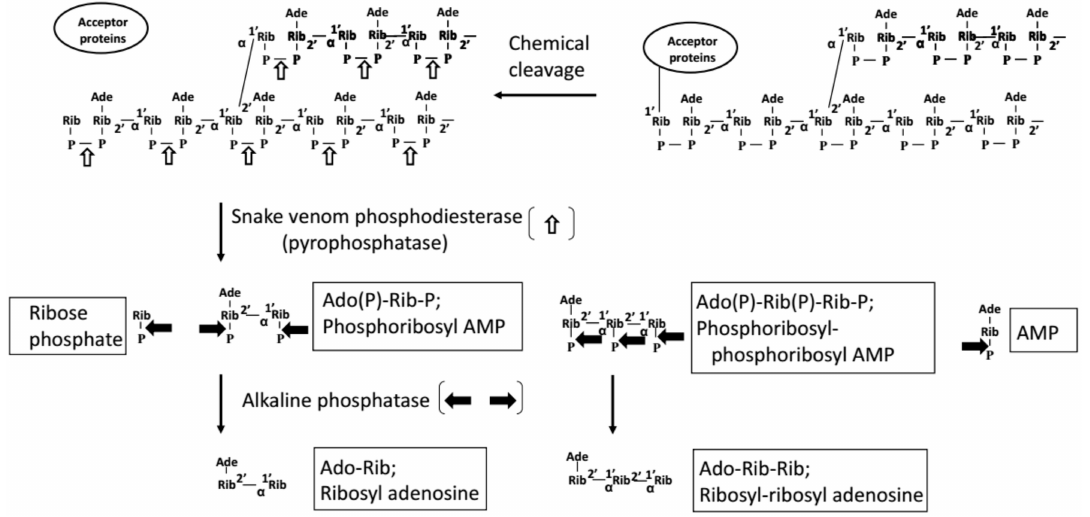
Figure 2. Specific degradation products of